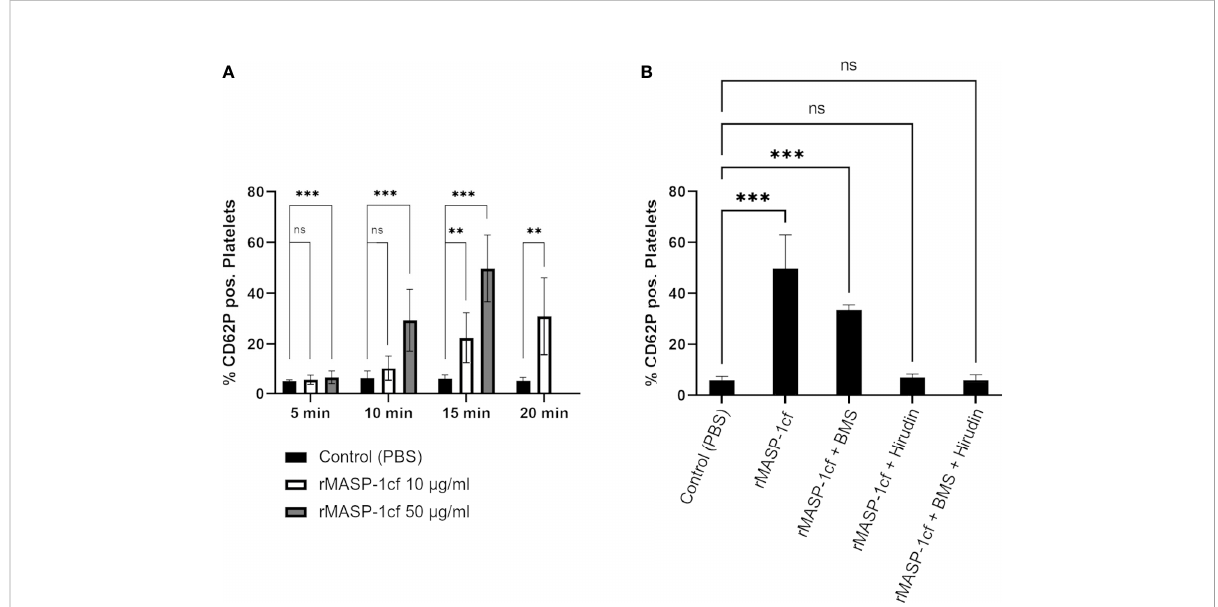
FIGURE 5 MASP-1 and platelet activation. Whole blood supplemented with corn trypsin inhibitor and acetylsalicylic acid was re-calci fi ed and incubated with rMASP-1cf (10 m g/ml and 50 m g/ml) and fi xed at different time points. The entire platelet population was identi fi ed with an anti-CD41 antibody conjugated with APC. The activated population was identi fi ed with an anti-CD62P antibody conjugated with BV421. (A) Addition of rMASP-1cf increased the percentage of platelets expressing CD62P (shown as mean with SD) in a time- and dose-dependent manner. Statistical analysis: The Shapiro-Wilk test con fi rmed normal distribution, and p-values for differences between groups were determined with an ANOVA test (ns not signi fi cant, * p ≤ 0.05, ** p ≤ 0.01, *** p ≤ 0.001). Number of experiments: Control: n=8; 10 m g/ml MASP-1: n=3; 50 m g/ml MASP-1: n=6). (B) The effect of 50 m g/ml rMASP-1cf was tested in the presence of PAR4 inhibitor BMS986120 and/or hirudin. The samples were fi xed after 15min. Addition of the PAR4 inhibitor signi fi cantly reduced the effect of rMASP-1cf, while addition of hirudin canceled it out completely. Statistical analysis: The Shapiro-Wilk test con fi rmed normal distribution, and p-values for differences between groups were determined with an ANOVA test (ns not signi fi cant, * p ≤ 0.05, ** p ≤ 0.01, *** p ≤ 0.001). Number of experiments: Control: n=8; MASP-1 only: n=6; MASP-1+ BMS: n=3; MASP-1+ Hirudin: n=4; MASP-1+ BMS + Hirudin: